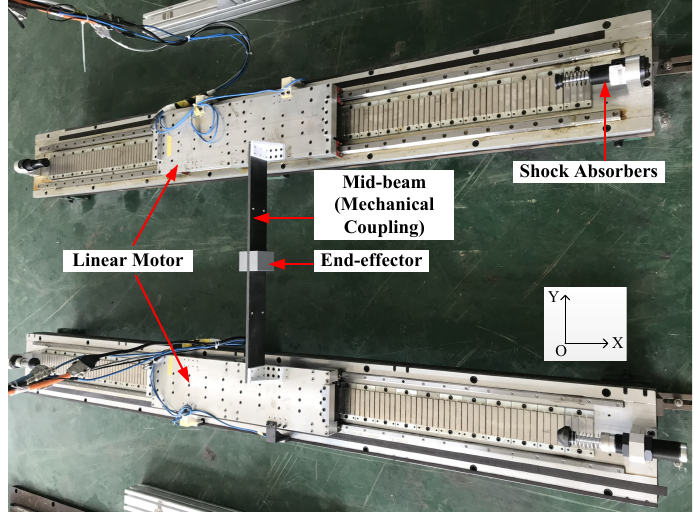
Figure 1. HGS driven by a linear